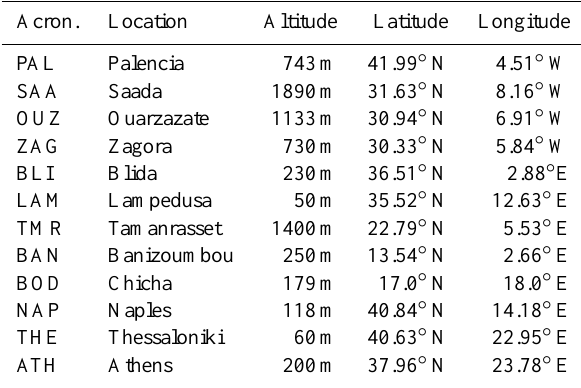
Table 1. Location of all AERONET and EARLINET stations in- cluding the BoDEx station Chicha in the Bod´el´e